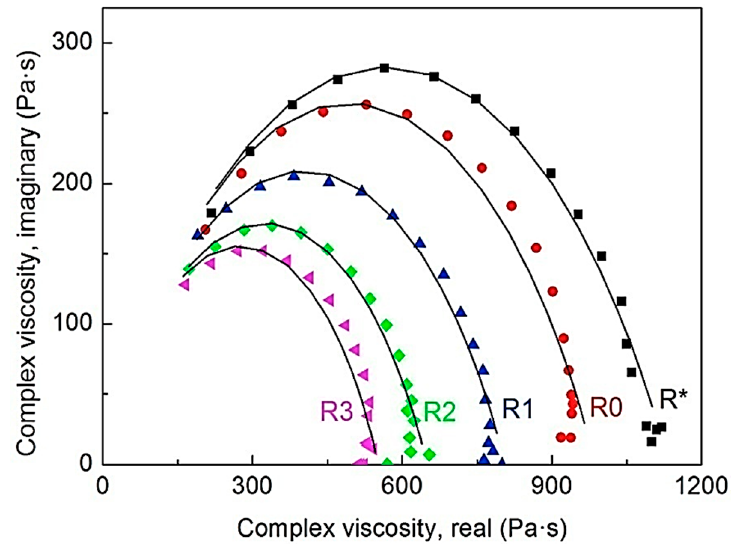
Figure 21. The plot obtained from the Cole–Cole model for original TPE pellets (R*) and neat TPE matrices after each reprocessing cycle (R0–R3). The best model fits are presented by solid lines, and the materials are processed through the injection molding (IM) technique directly by R* [30] (reprinted with permission from Elsevier TM ).